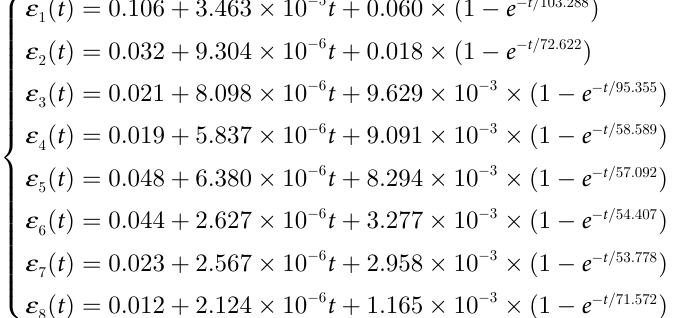
where J stands for elastic compliance; J = 1/ E ; J ( t ) represents viscosity compliance; J ( t ) = t / e e 1 v v η 1 ; J ve ( t ) represents the viscoelastic compliance; J ve ( t ) = [1-exp(- E 2 t / η 2 )]/ E 2 , σ 0 represents the stress on the material; and t is time of applied stress. According to the expression of creep com- pliance J ( t ), the elastic compliance J is the instantaneous elastic deformation under the stress e applied to paddy soil, which does not change with time. The coefficient of viscosity compliance J v ( t ), which increases slowly and linearly with time, is the reciprocal of the coefficient viscosity η 1 , where the creep curve shows the creep rate of uniform creep stage of paddy soil. The visco- elastic compliance J ( t ) is influenced by the delay elastic modulus E and delay viscosity coeffi- ve 2 cient η . As time increases, the viscoelastic compliance J ( t ) gradually increases, then the 2 ve growth rate slows down to a fixed value. The creep curve illustrates the decelerating creep stage of paddy soil. The creep curve fitting results of NT and PT paddy soil in Table 2 were transformed accord- ing to formula (1) to obtain the components of total creep strain of both soils at each moisture content level. The specific expressions are as follows: